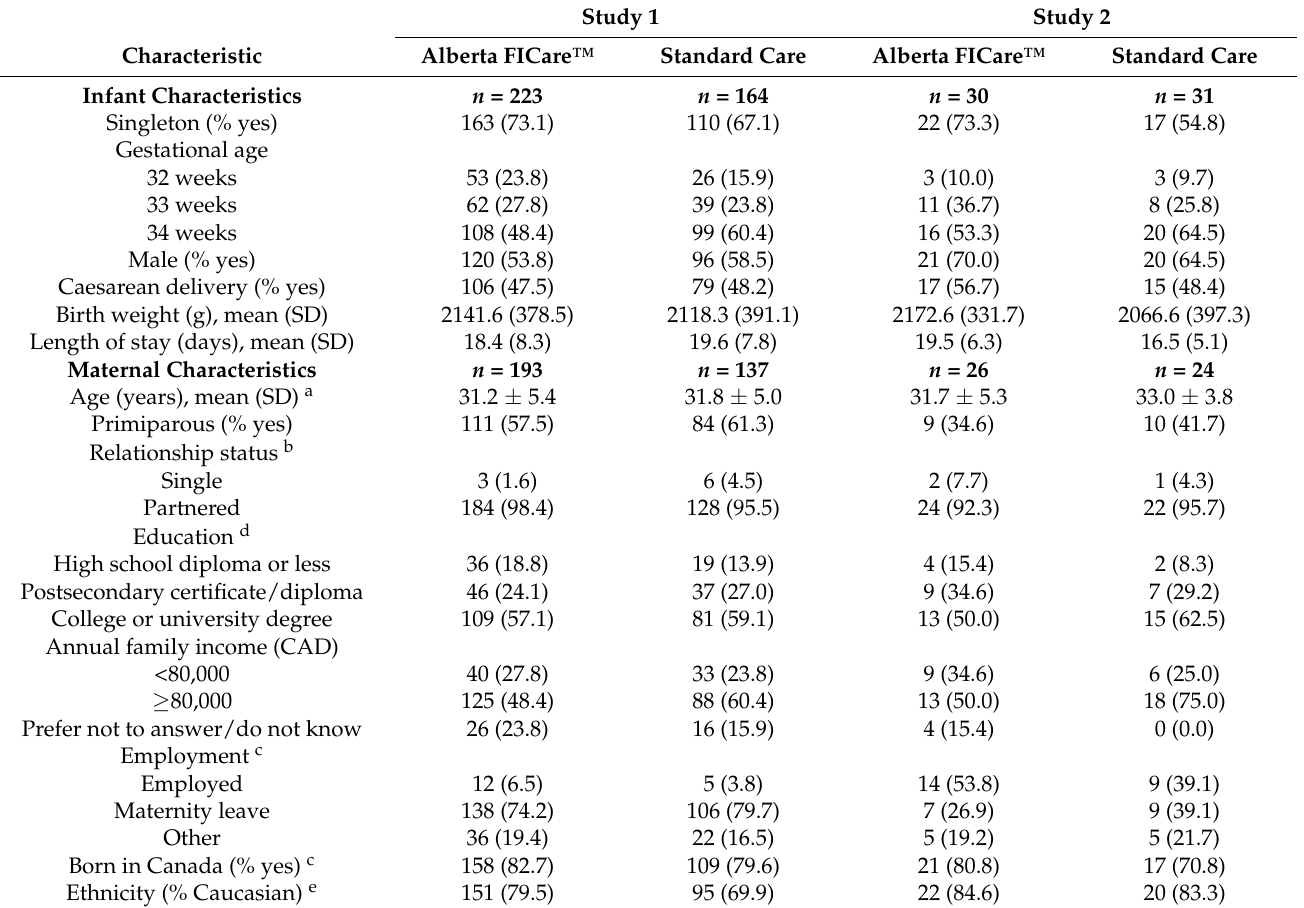
Table 2. Infant and mother